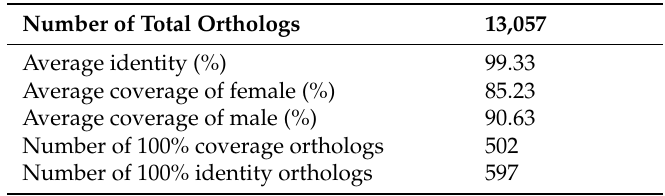
Figure 3. Gene discovery rate of each transcriptome database. Venn diagram to compare ortholog numbers annotated in the female and male Haliotis discus hannai . Table 2. Ortholog statistics between female and male Haliotis discus hannai .